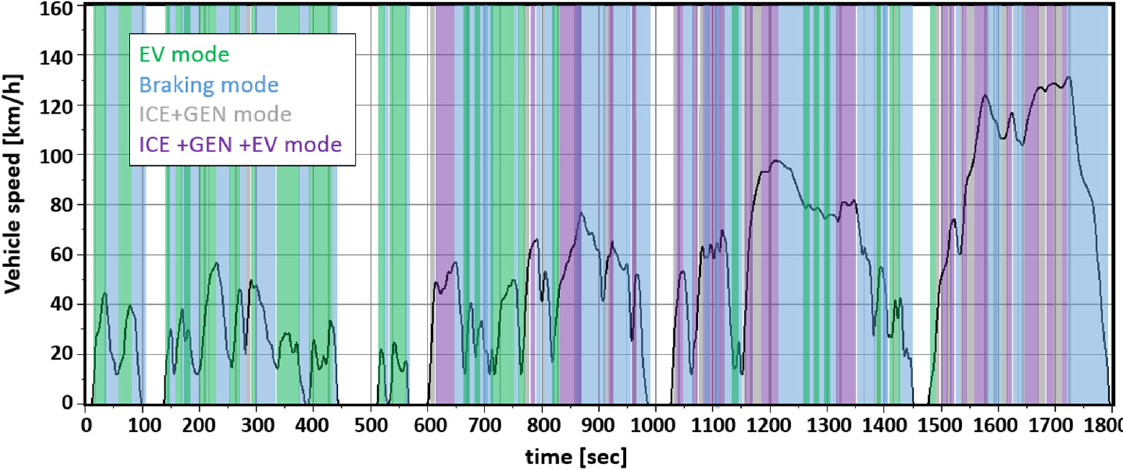
Figure 10. Final mode switches for a serial hybrid on WLTC.